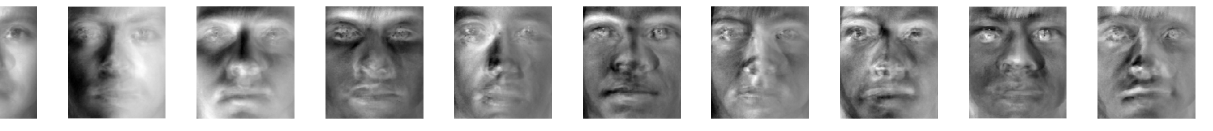
Figure 1. Eigenfaces